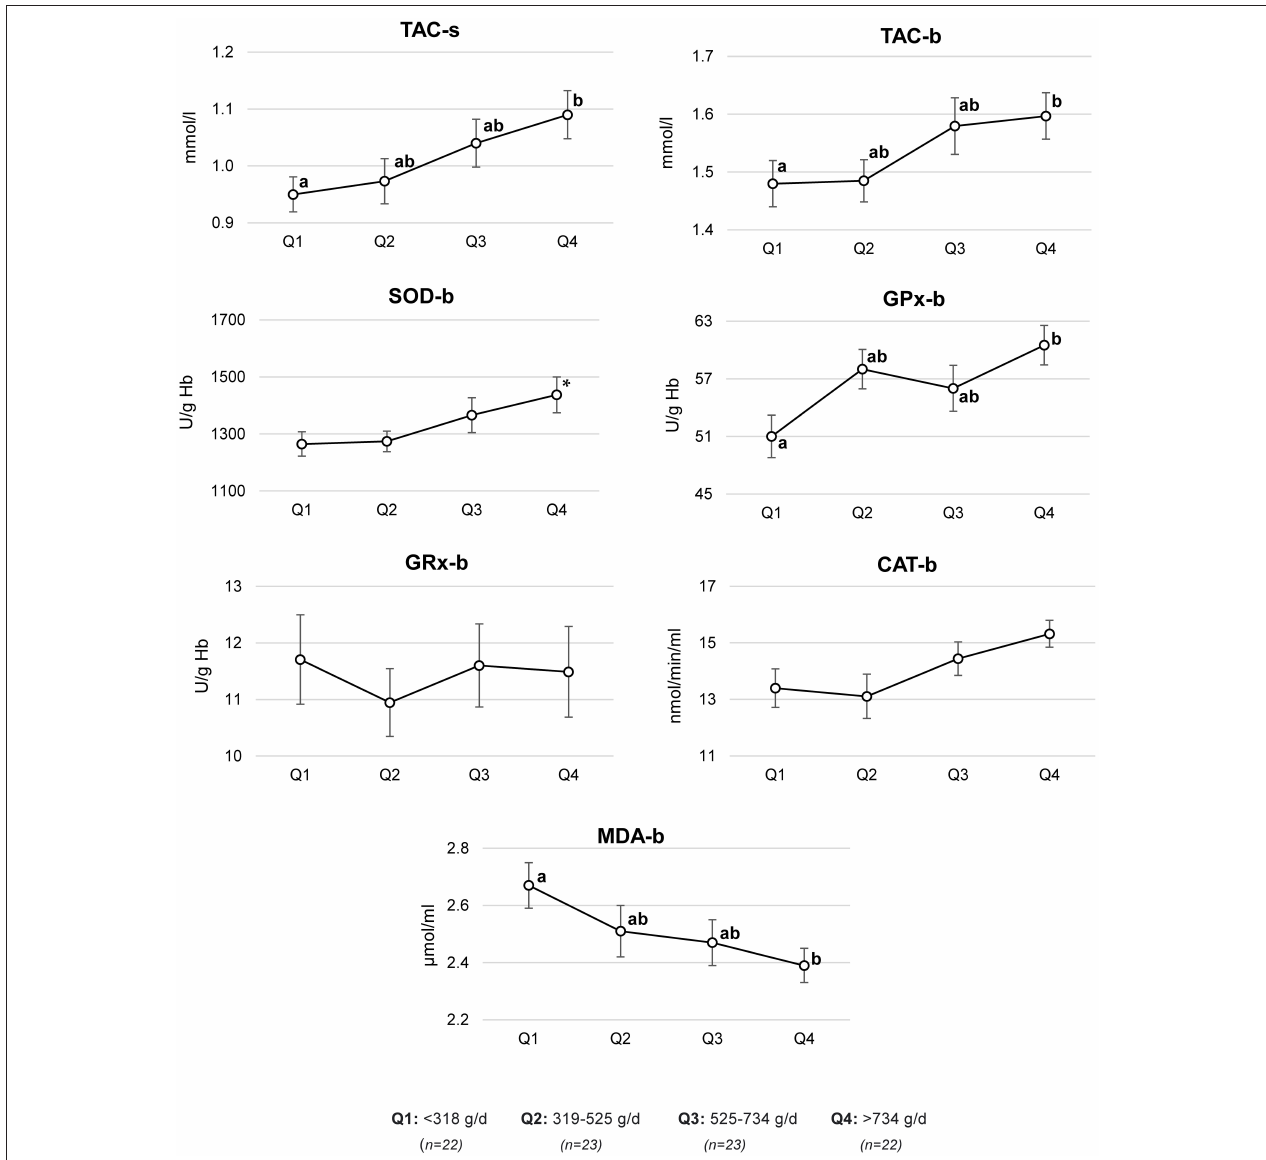
FIGURE 2 | Antioxidant status parameters by quartiles (Q) of fruit and vegetable consumption. Mean ± SE of antioxidant status parameters were estimated based on a multivariate regression model adjusted for age (years, continuous), BMI ( < 18.5, 18.5–24.9, and > 24.9 kg/m 2 ), sitting time (h/d, continuous), physical activity level (MET-h/week, continuous), smoking (ever, never), alcohol consumption (ever, never), supplement use (yes, no), wearing briefs and boxer shorts (ever, never), and energy (kcal/d, continuous); TAC-s, total antioxidant capacity in semen; TAC-b, total antioxidant capacity in blood; SOD-b, superoxide dismutase activity in blood; GPx-b, glutathione peroxidase activity in blood; GR-b, glutathione reductase activity in blood; CAT-b, catalase activity in blood; MDA-b, malondialdehyde concentration in blood; a , b different letters indicate statistically significant differences between quartiles; p -value ≤ 0.05 (Mann–Whitney U-test); * p -trend between Q1 and Q4, p -value = 0.08 (Mann–Whitney